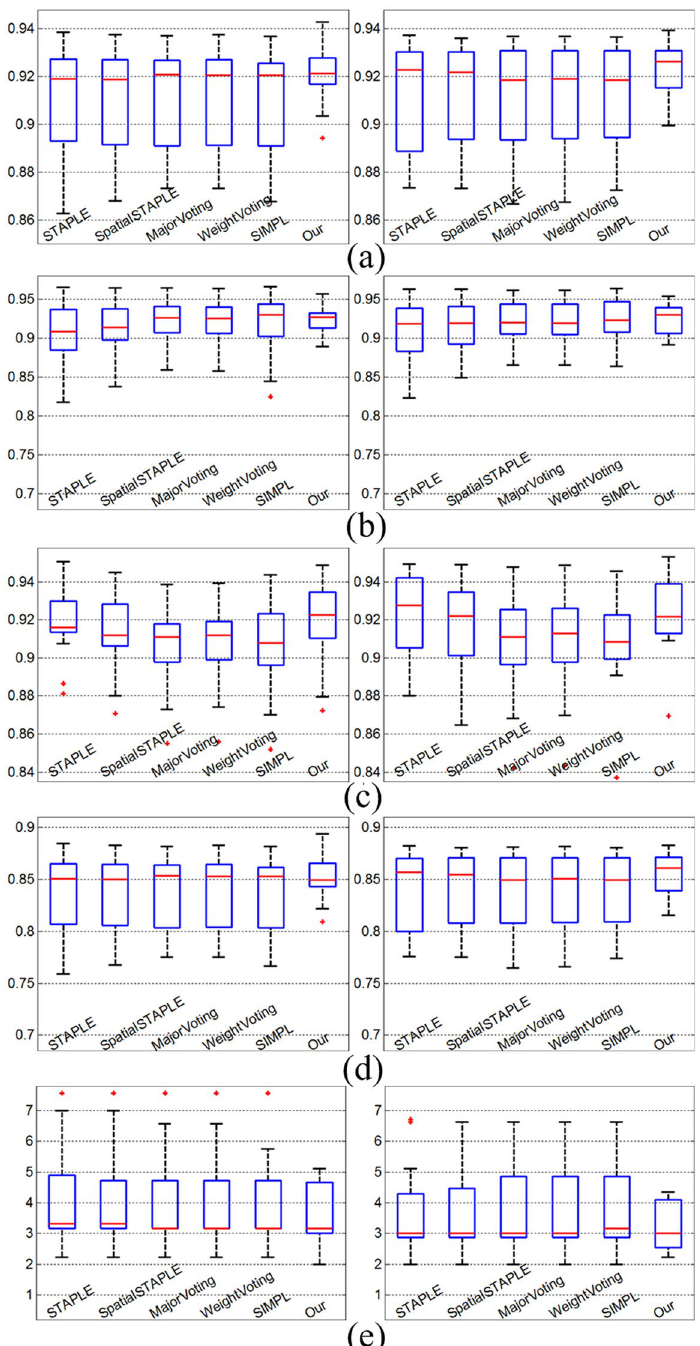
Figure 6. Box-plot of performance metric on the MICCAI dataset. The left column is left thalamus and the right column is right thalamus. ( a ) Similarity index ( SI ), higher values implying greater volumetric overlap with the manual segmentation, ( b ) Precision ( P ), ( c ) Recall ( R ), ( d ) Relative Overlap ( RO ) and ( e ) Hausdorff Distances ( HD ), lower values implying a surface closer to the manual